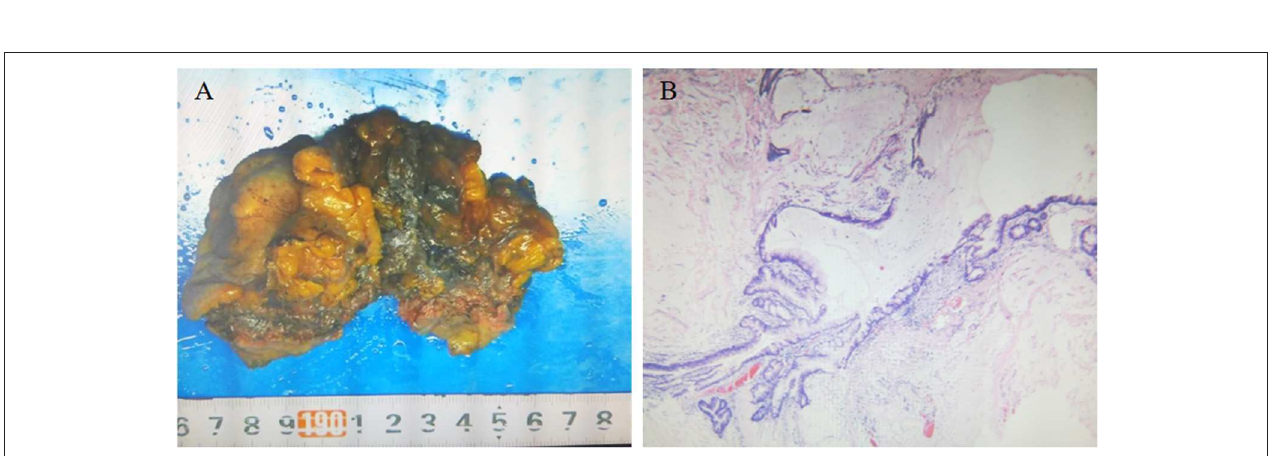
FIGURE 3 | (A) Gross pathology showing the resected umbilical urethral tumor specimen. The swollen tumor material was brittle and adhered to the bladder wall. The cut surface was grayish white and covered with a jelly-like substance, and part of the bladder mucosa was visible. (B) Microscopic pathology (hematoxylin and eosin staining × 40) confirming urachal cancer (grade II mucinous adenocarcinoma) with calcification and cancer tissue infiltration into the bladder wall muscle layer.